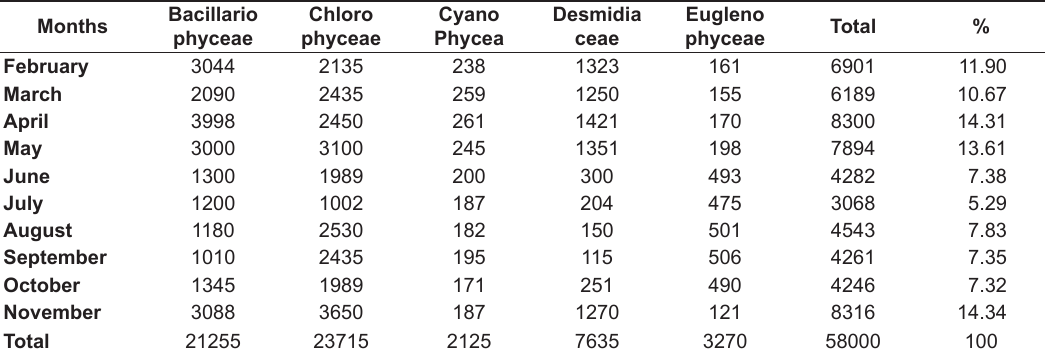
Table 2. Monthly distribution of the phytoplankton families found in Nasarawa reservoir during the study period.